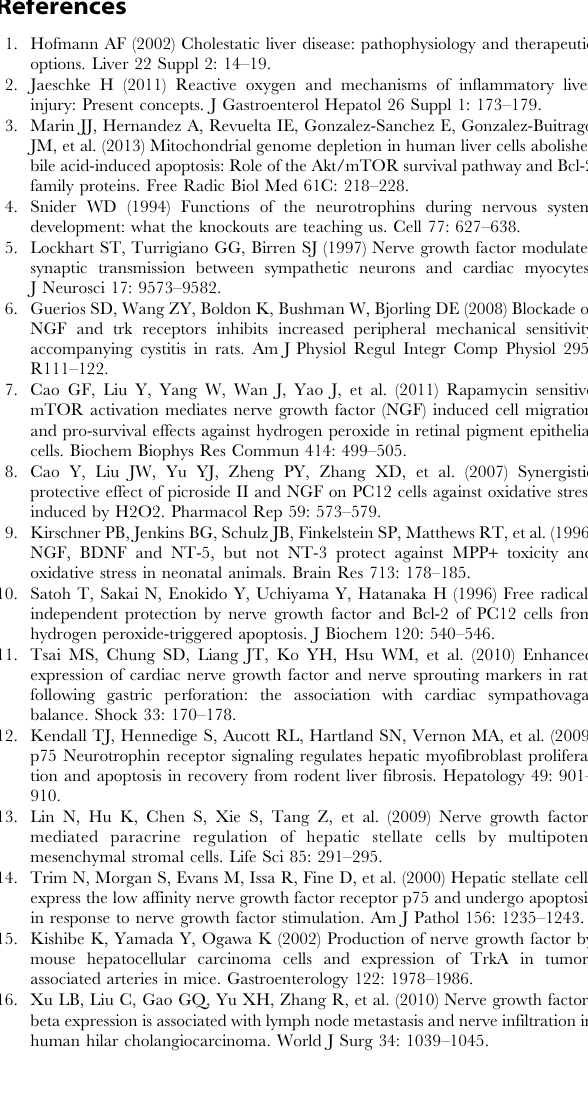
Figure S3 Effect of methylprednisolone (MP) treatment on survival of mice with experimental cholestatic liver injury. Normal saline (NS) was used as solvent control group. Figure S4 TNF- a , IL-1 b and IL-6 did not induce NGF expression. Primary hepatocytes were isolated from rats and grown on collagen I-coated dishes. Cells were treated with TNF- a , IL-1 b , and IL-6 at the indicated doses (ng/mL) for 6 hrs. Total RNA was extracted and subjected to qPCR analysis for NGF mRNA levels. Expression levels were normalized to internal control actin gene. Note that none of cytokines increased transcription of NGF gene in cultured primary hepatocytes. Data are shown in mean 6 SD. * indicates P , 0.05 compared to the negative controls (NC). Figure S5 Expression levels of TrkA and p75NTR in primary rat hepatocytes. Primary hepatocytes isolated from rat livers were treated with either recombinant TGF- b 1 at 50 ng/ mL or H 2 O 2 at 500 m M for 24 hrs. Protein lysates were collected and subjected to Western blot detection for TrkA and p75NTR expression.